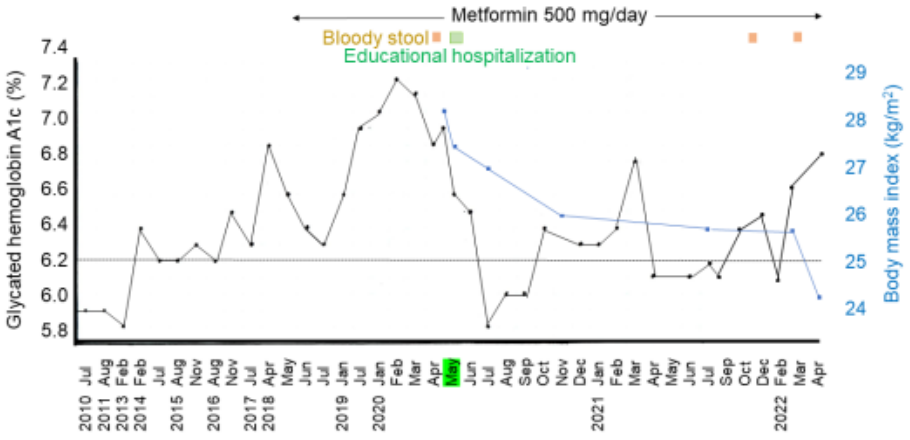
Figure 2. Chronological change of glycated hemoglobin A1c (%) and body mass index (kg/m 2 ). The reference range for glycated hemoglobin A1c is 4.6–6.2% according to the National Glycohemoglobin Standardization Program. A body mass index higher than 25 is defined as obesity in Japan.